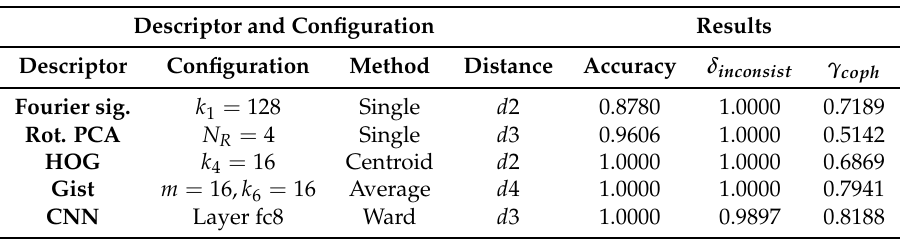
Table 3. Optimal results of the high-level clustering for each description